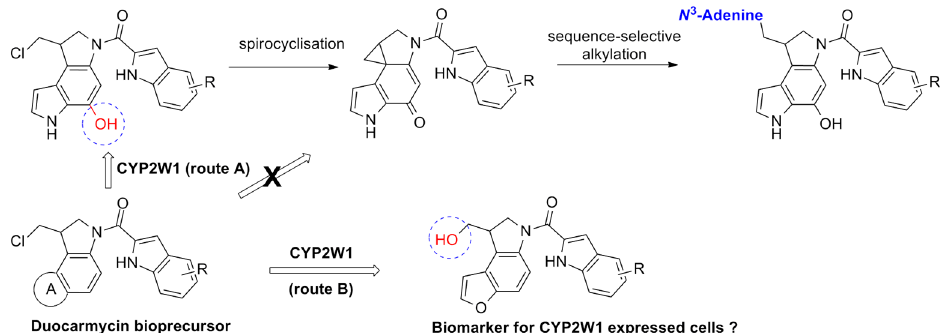
Figure 1. Proposed pathway for CYP activation of duocarmycin biopersursor substrates 3,4 (A = pyrrole or furan ring).